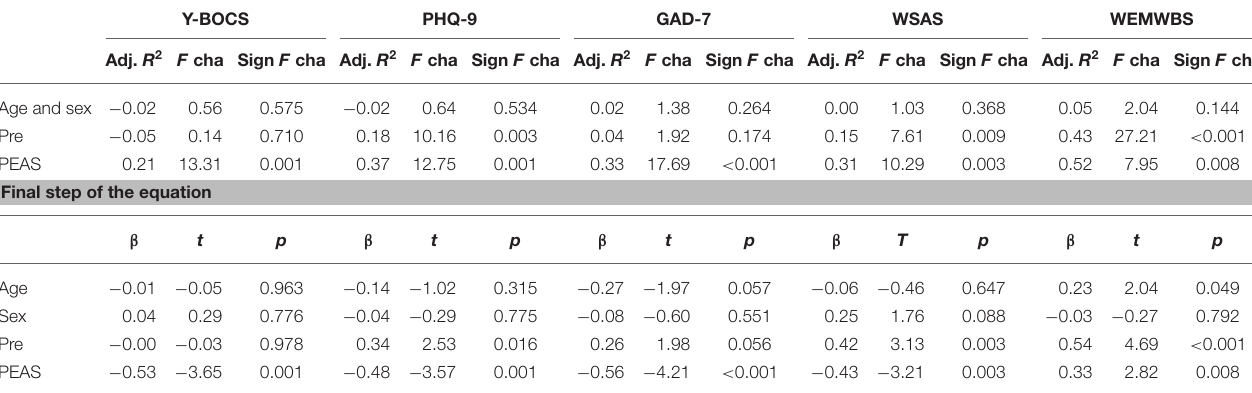
TABLE 3 | Treatment adherence as a predictor of 3-month follow-up. Y-BOCS PHQ-9 GAD-7 WSAS